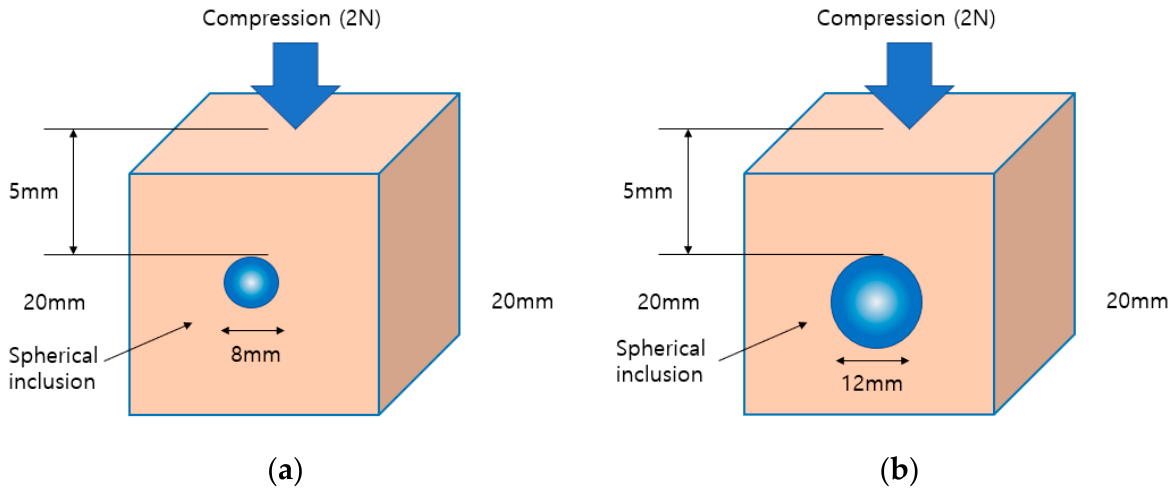
Figure 28. ( a ) Includes 12-mm tissues. ( b ) Includes 8-mm tissues.